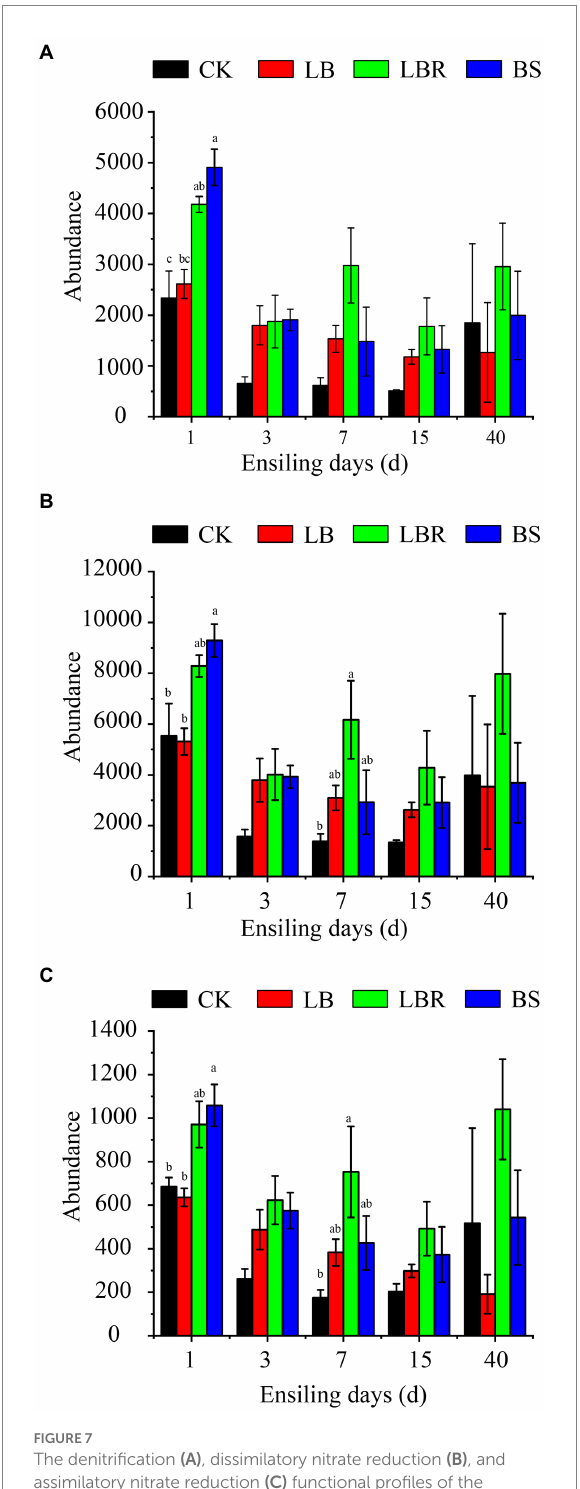
FIGURE 7 The denitrification (A) , dissimilatory nitrate reduction (B) , and assimilatory nitrate reduction (C) functional profiles of the microbial communities in sorghum-sudangrass after ensiling for 1, 3, 7, 15, and 40 days (CK, control; LB, Lactobacillus buchneri ; LBR, Lactobacillus brevis; BS; Bacillus subtilis; different lowercase indicate differences between treatment groups at the same time at the 0.05